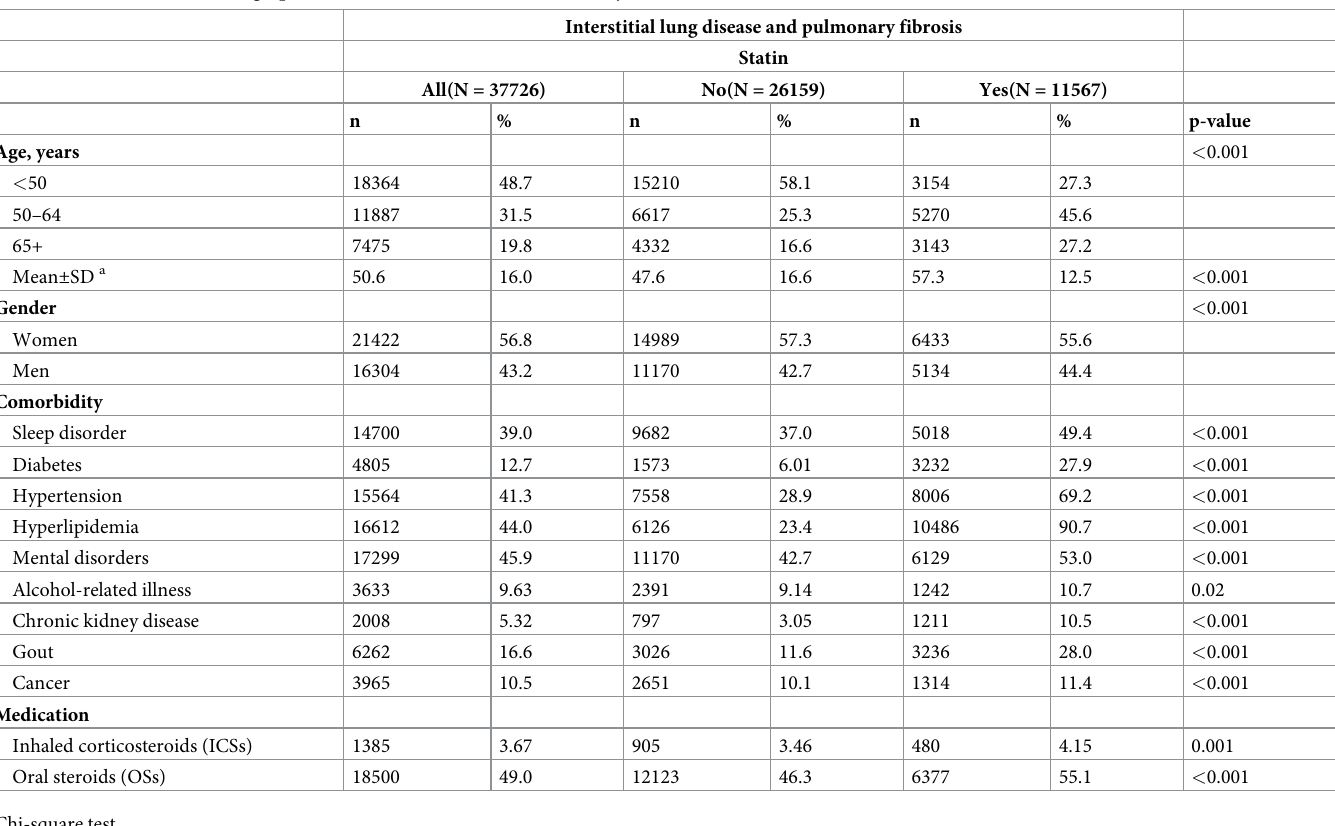
Table 1. Distributions of demographic and clinical comorbid status in study